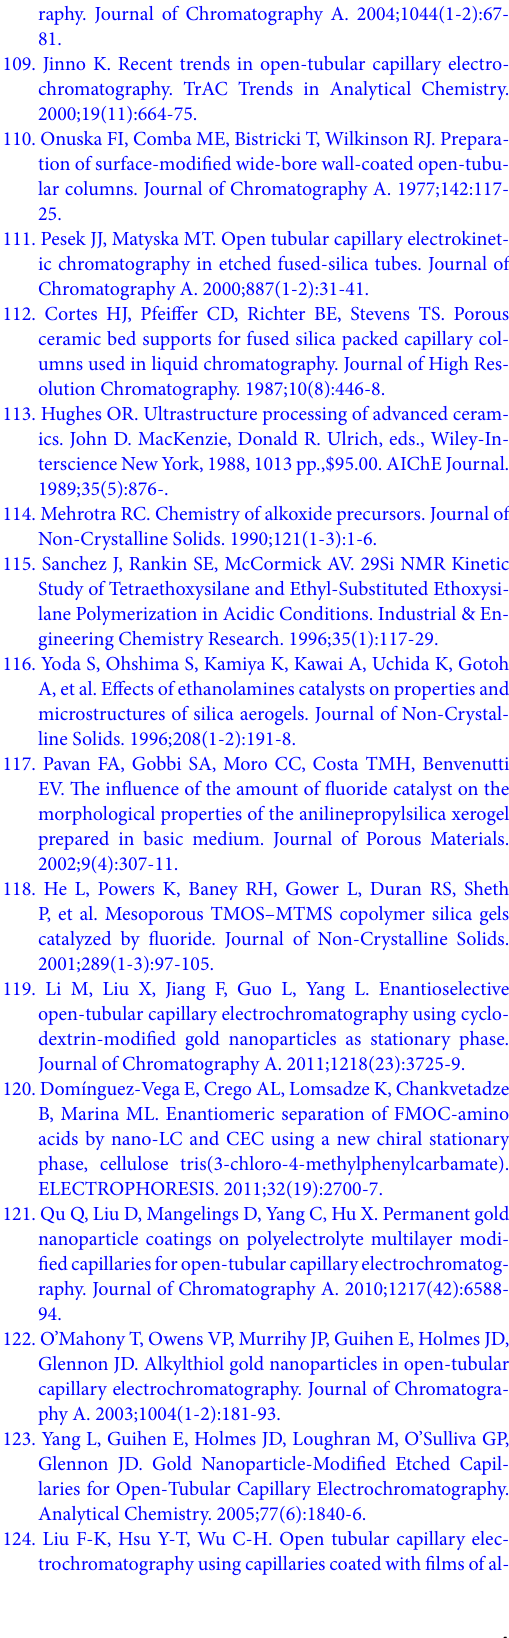
49 Nanochem Res 6(1): 25-52, Winter and Spring